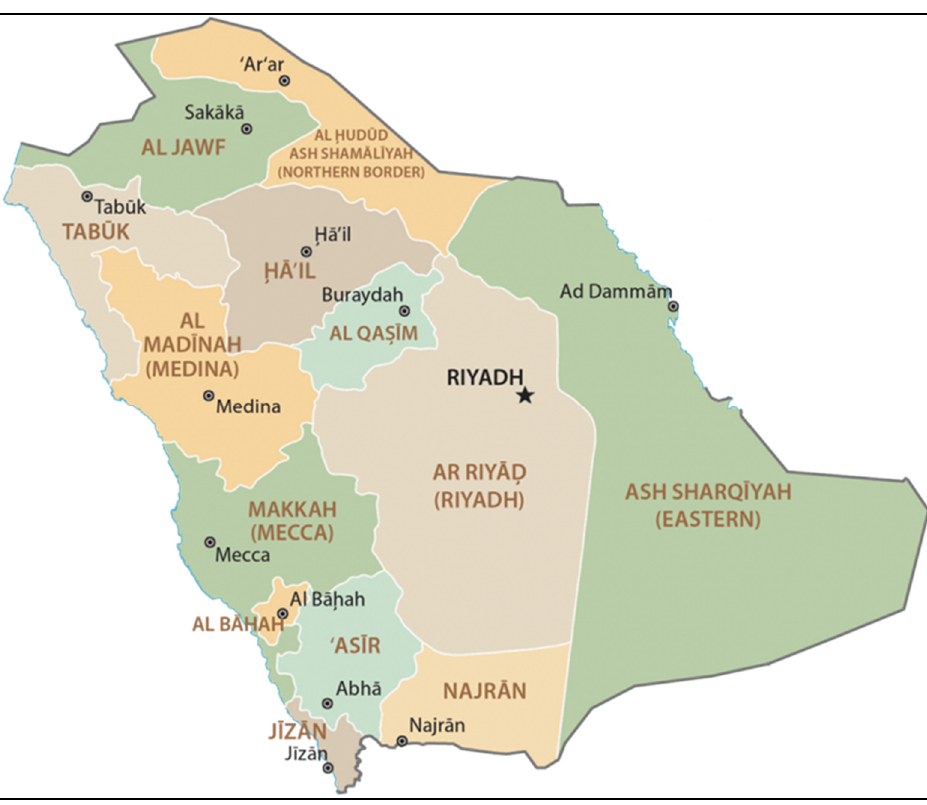
Figure 1. Saudi Arabia region map.